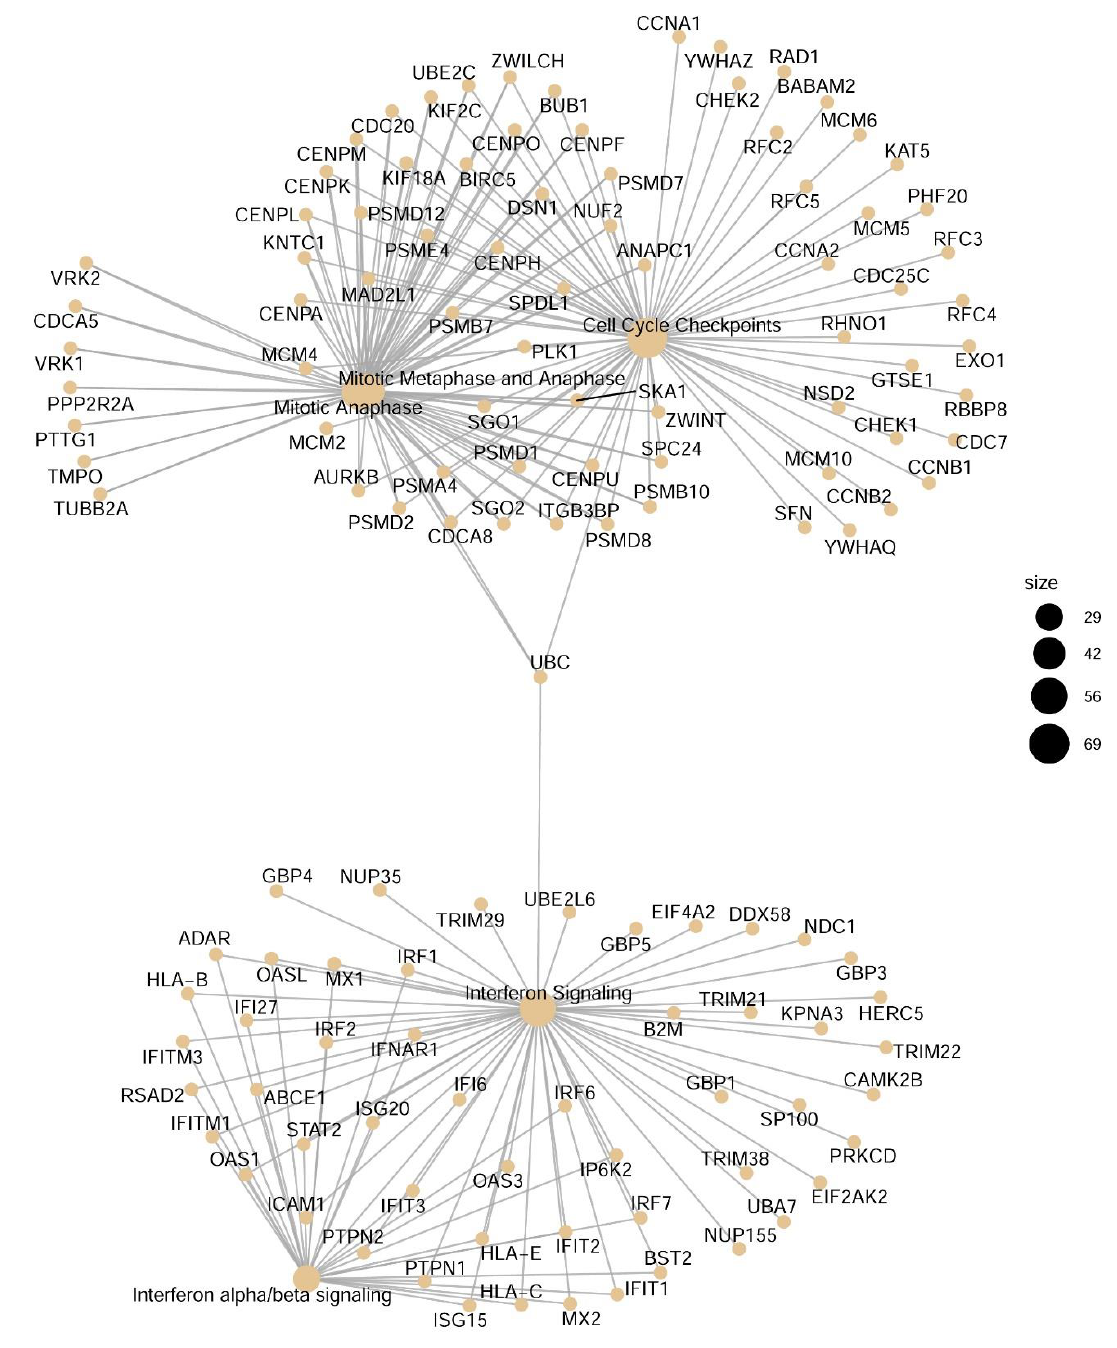
Figure 6. Integrated network analysis of RSV-induced transcripts with differential usage (DIU) were analyzed for network interaction. Node size is indicated in the legend.